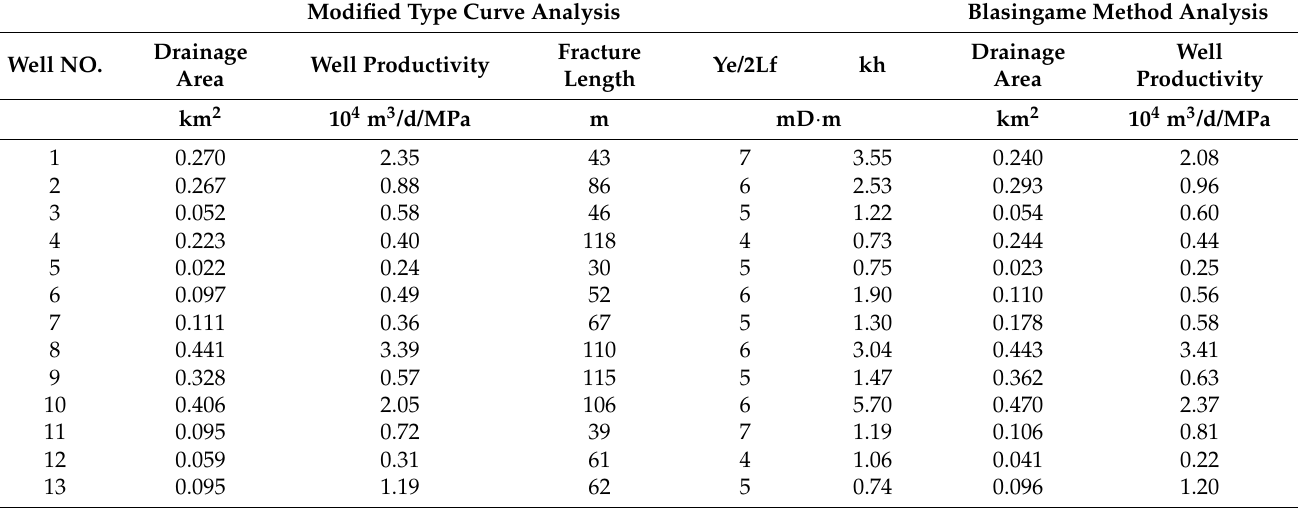
Table 4. Post-fracturing evaluation of 13 wells by the modified type curves along with the results analyzed by the conventional Blasingame method for